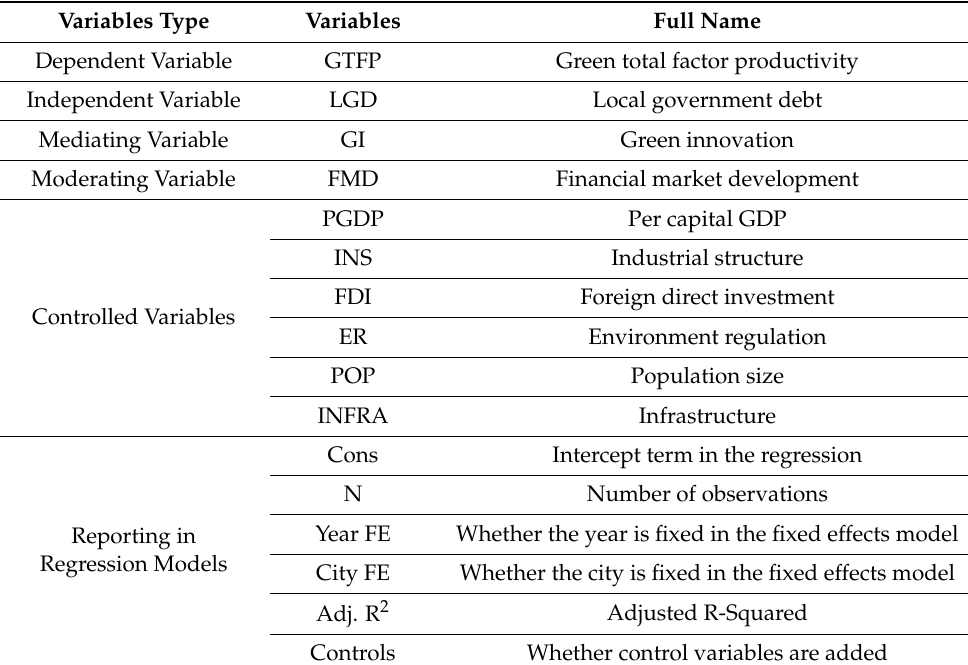
We list all the abbreviations in the full text in the table below. Table A2. Abbreviations and full